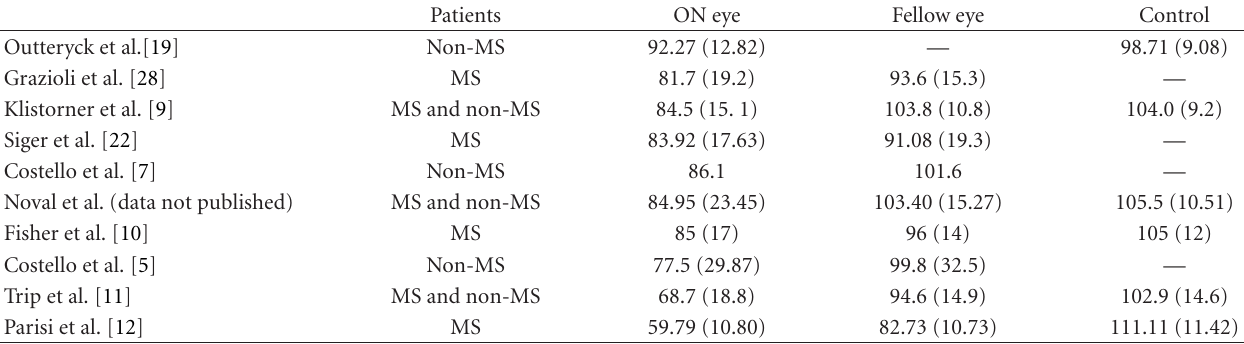
Table 1: Comparison of RNFL thickness ( µ m) between both eyes of patients who have su ff ered unilateral optic neuritis and healthy control subjects. Values are expressed as mean (standard deviation).